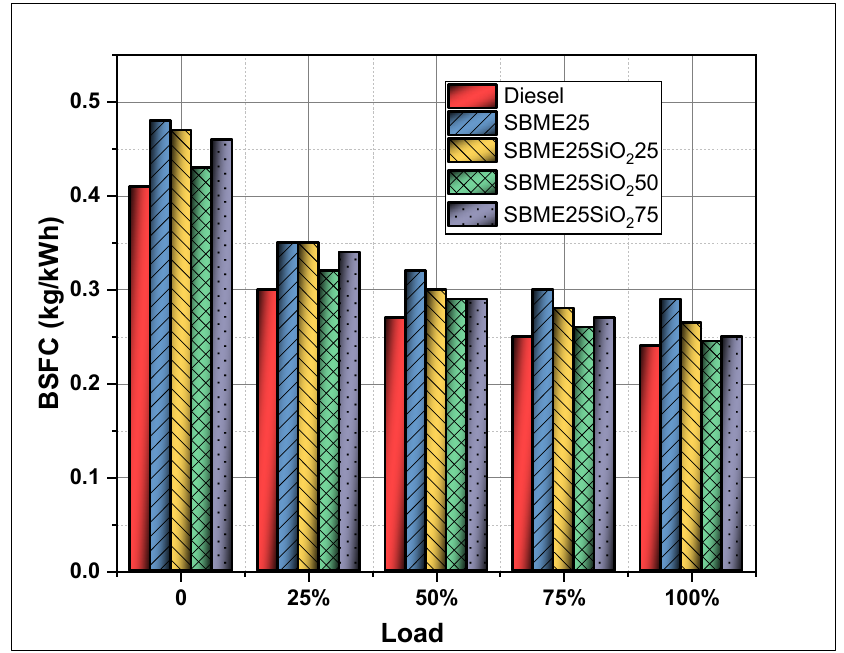
Figure 9. Effect of SiO 2 nano-additives on Brake Specific Fuel Consumption (BSFC) at varying loads.